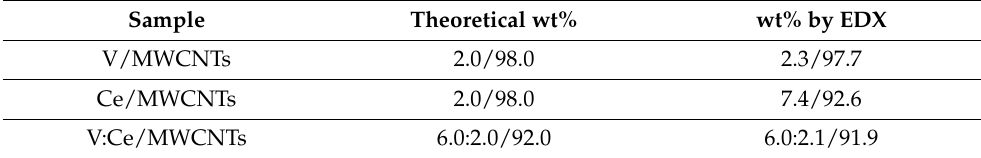
Table 1. Composition of metal oxide-modified MWCNTs.